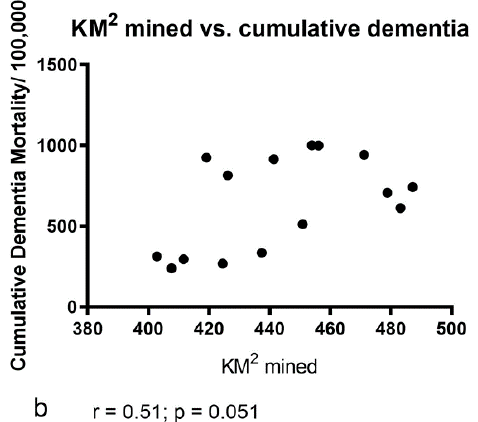
Figure 11. ( a ) No significant correlation was found between the extent of mining (km 2 ) vs. the mean number of age-adjusted deaths from dementia / 100,000 population (r = 0.51; p = 0.051; 15 xy pairs). ( b ) No significant correlation was found between the extent of mining (km 2 ) vs. the cumulative number of age-adjusted deaths from dementia / 100,000 population (: r = 0.51; p = 0.051; 15 xy pairs). Comparing the yearly km 2 mined per year vs. the number of distinct sites mined per year shows that the former remained relatively flat over the 15 years whereas the latter steadily increased (Figure 12).